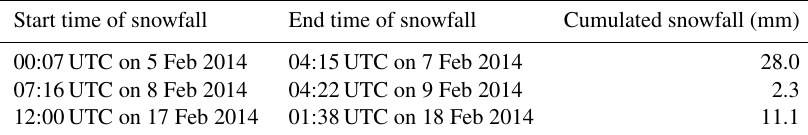
Table 1. Information of three snowfall cases used in this study. Start time of snowfall